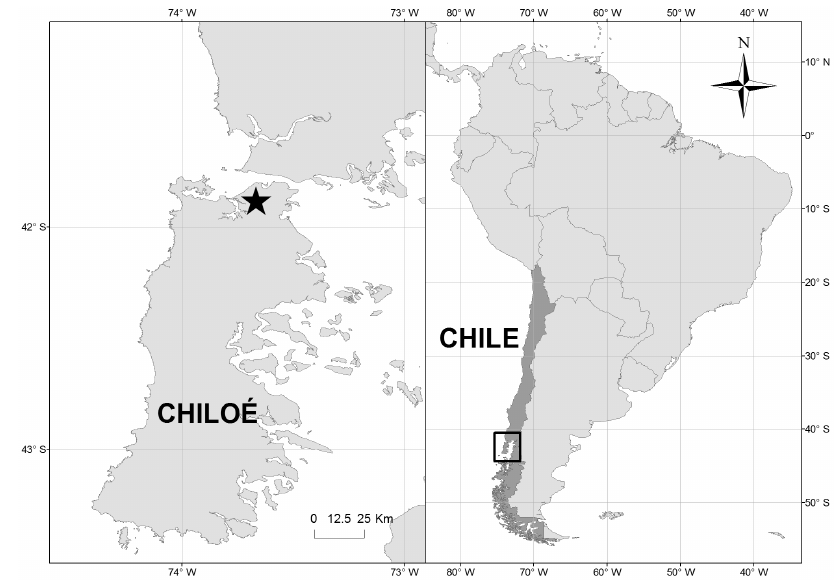
Figure 1. Location of the Senda Darwin Biological Station (marked with a star) at Chiloé Island.